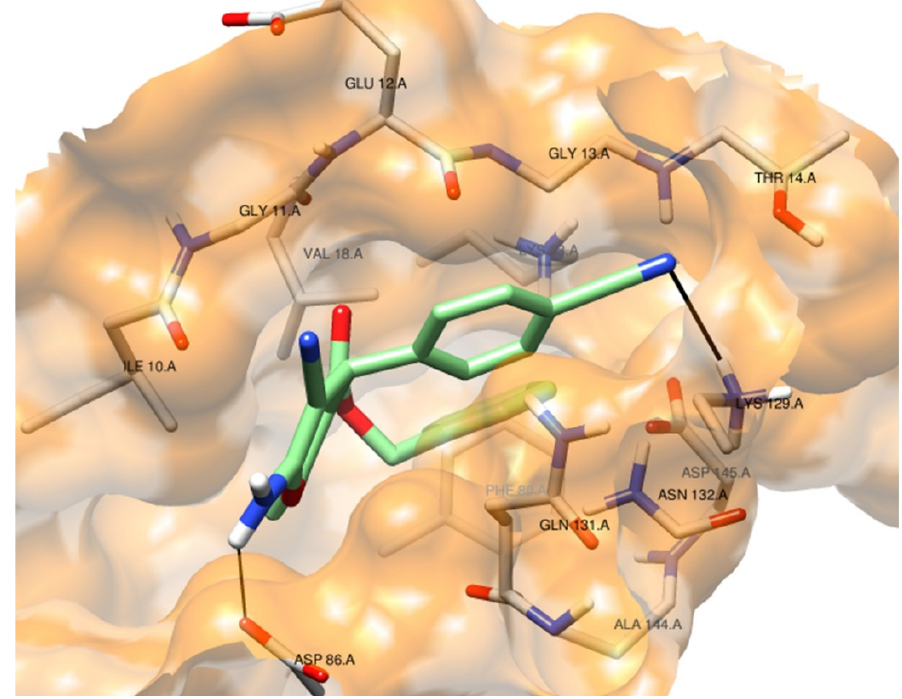
Figure 11. Three-dimensional model of binding interactions of compound 4K after docking calcula- tions in the ATP binding pocket of CDK2. Hydrogen bond (black lines), hydrogen atoms (white), nitrogen atoms (blue), and oxygen atoms (red).